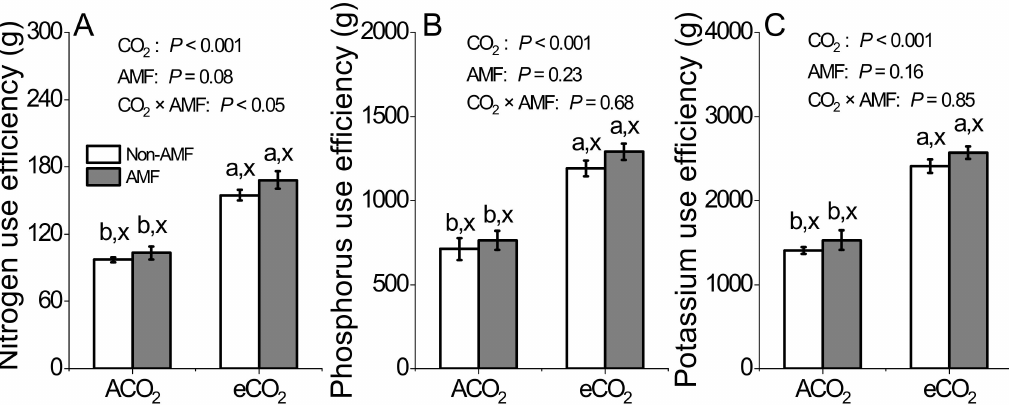
Figure 4. Soil organic carbon ( A ), soil available N ( B ), soil NH 4+ –N ( C ), soil NO 3- –N ( D ), available phosphorus ( E ), and soil available potassium ( F ) in soils of Funneliformis mosseae inoculated faba beans grown for 12 weeks at ambient CO 2 (ACO 2 ) and elevated CO 2 (eCO 2 ). Data (means ± SE, n = 3) followed by different letters indicate significant differences between CO 2 treatments for the same AMF inoculation (a, b) and between AMF inoculations for the same CO 2 treatment (x, y) at P < 0.05, as revealed by Tukey’s test. Statistical comparisons (two-way ANOVA) between AMF or CO 2 treatments as well as their interaction (AMF × CO 2 ) are presented for each